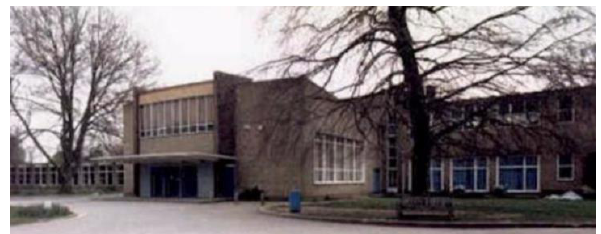
Figure 2. The outdoor view of the ‘impington’ Village College designed by Gropius in 1936(A plan conceived in the mind. Impington Village College,